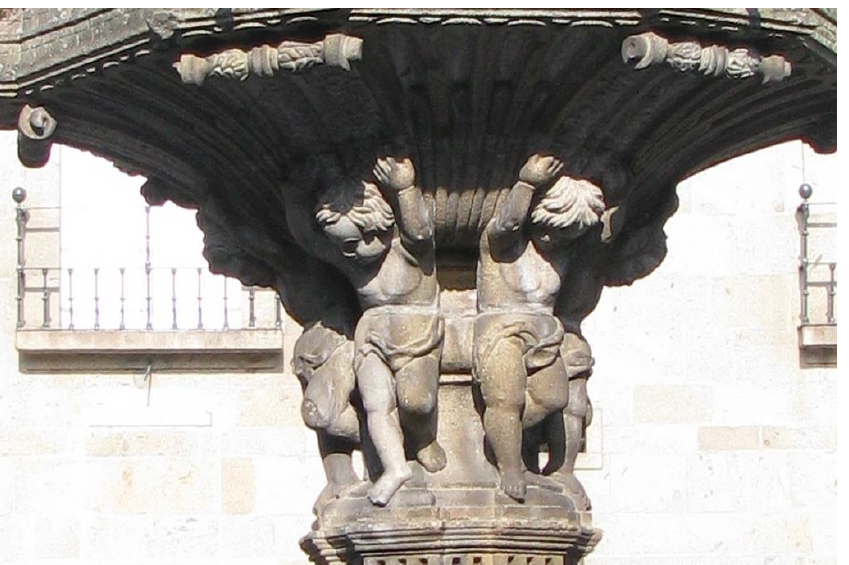
Figure 6. Image from a granite fountain (location of specific details will be an excruciating